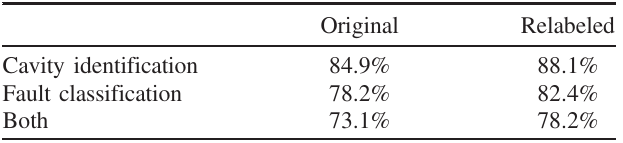
TABLE III. Model accuracies as computed for the original set of labels and after a subset of events — including all that disagreed with the models — had been relabeled.